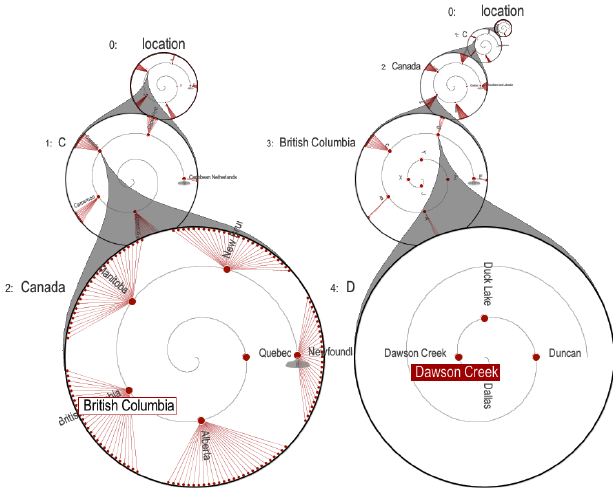
Figure 12. Selecting a location by navigating through a country- state-city tree.